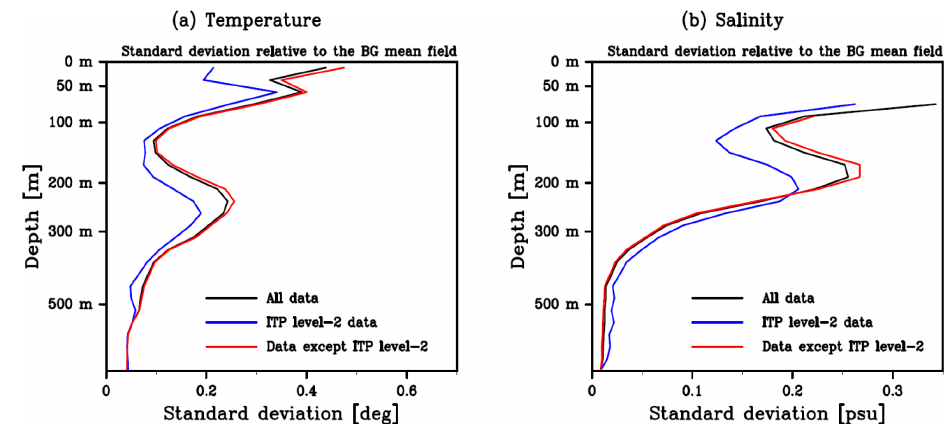
Figure B1. Vertical profiles of standard deviation of (a) temperature and (b) salinity in the Amerasian Basin. The black, blue, and red lines indicate the standard deviation calculated from all data, ITP level-2 data, and data except ITP level-2 data, respectively. The standard deviation at each location is calculated by the deviation from the background mean field, and then an averaged standard deviation in the entire basin is